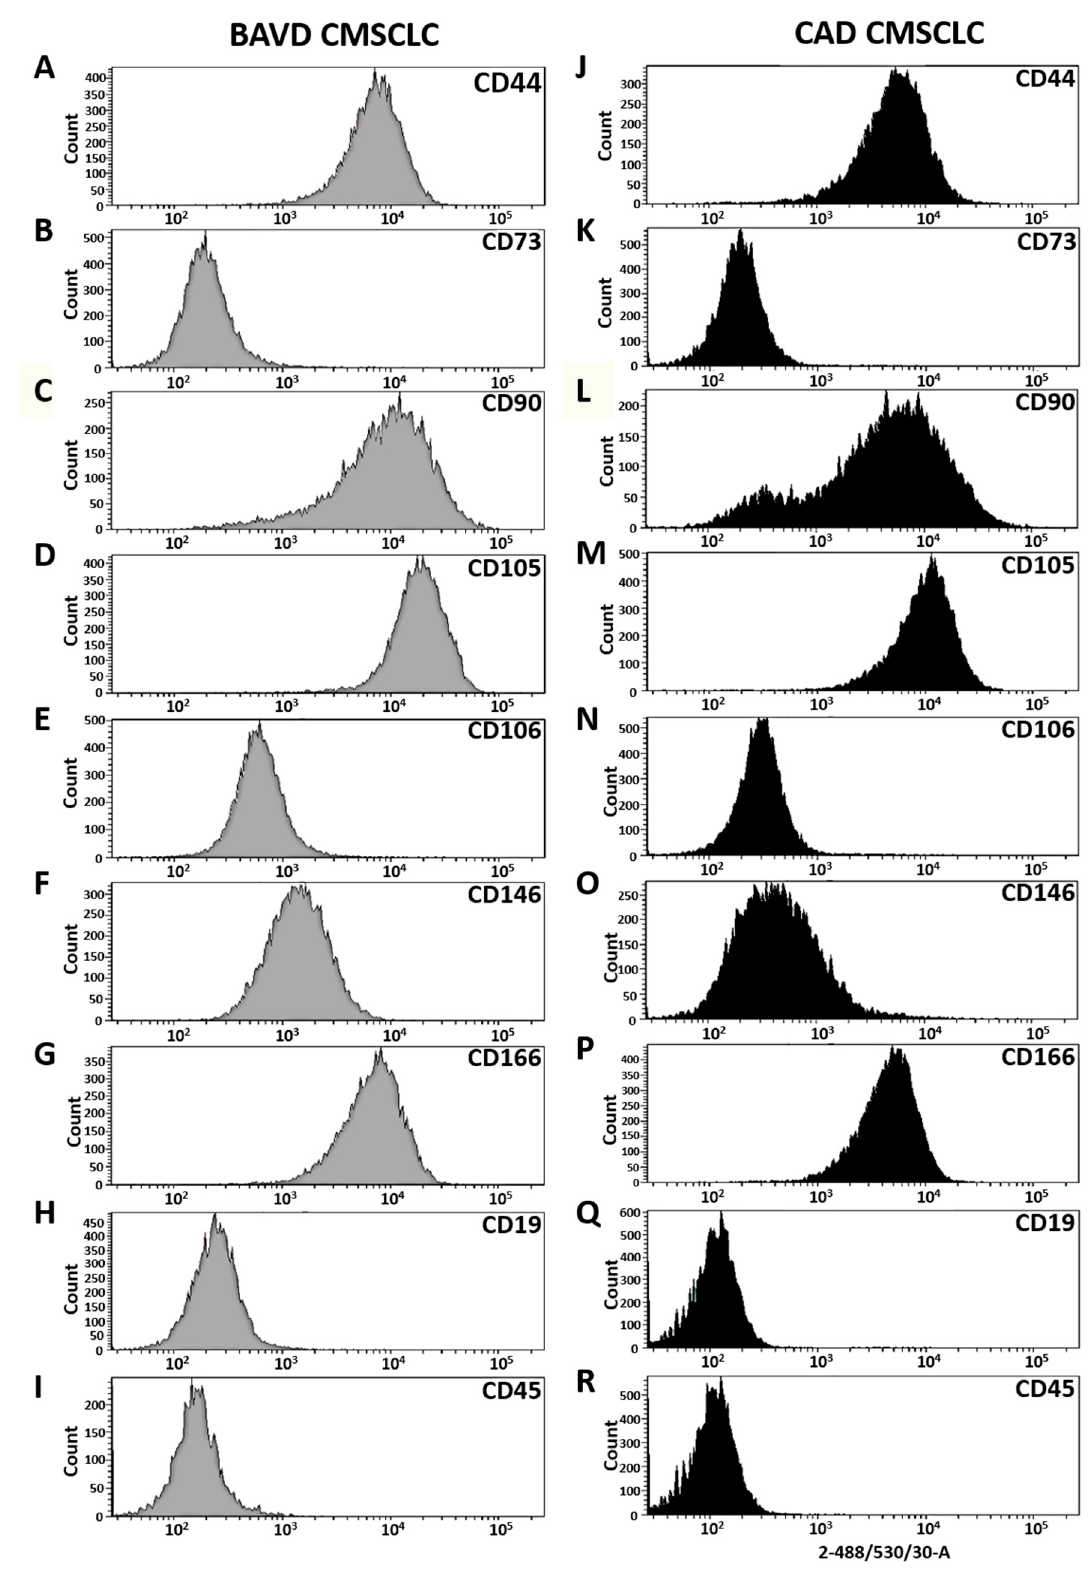
Figure 2. Immunophenotyping of MSC-associated cell surface antigens. Results for CMSCLCs immunolabelled with antibodies to human CD cell surface antigens. BAVD-CMSCLC express a number of markers of MSCs ( A – G ) but are negative for CD19 ( H ) and CD45 ( I ). CAD-CMSCLC also express the expected MSC markers ( J – P ) but are also negative for CD19 ( Q ) and CD45 ( R ).